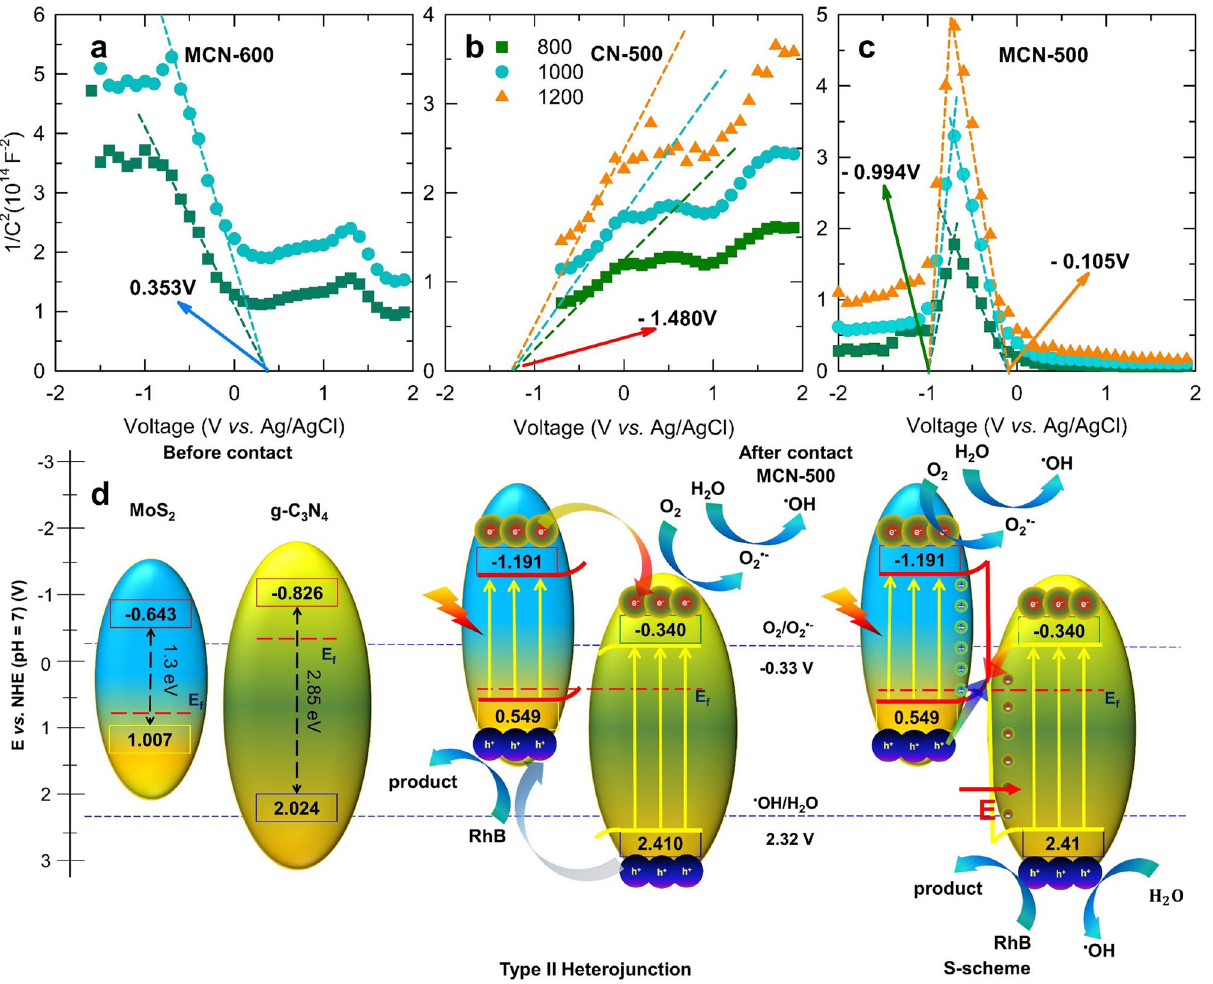
Figure 5. Mott–Schottky plots of ( a ) MCN-600, ( b ) CN-500; and ( c ) MCN-500; ( d ) schematic diagram of band alignment of heterojunction and S-scheme charge transfer on interface of MoS 2 and g-C 3 N 4